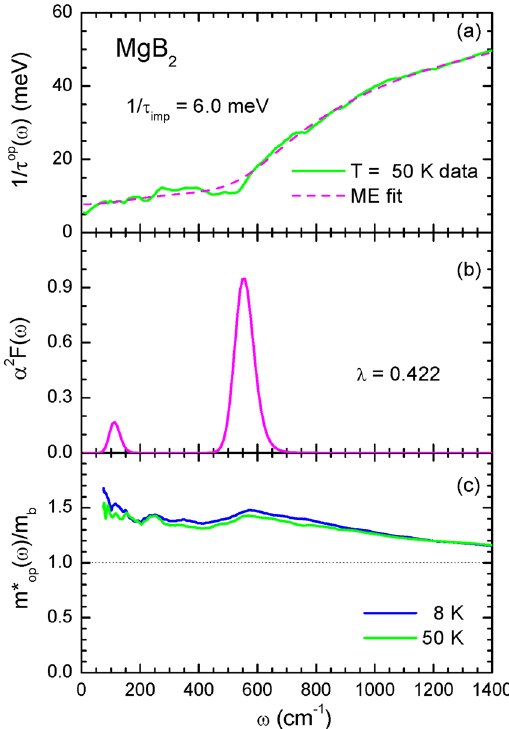
Figure 3. ( a ) The optical scattering rate of MgB 2 at 50 K and its maximum entropy (ME) fit, obtained from Shulga et al .’s formula 18 with the impurity scattering, 1/ τ imp = 6.0 meV. ( b ) Extracted electron-phonon spectral density function, α 2 F ( ω ), from the ME fit. ( c ) The optical effective mass to band mass ration, m * ( ω )/ m b , at temperatures T = 8 K and T = 50